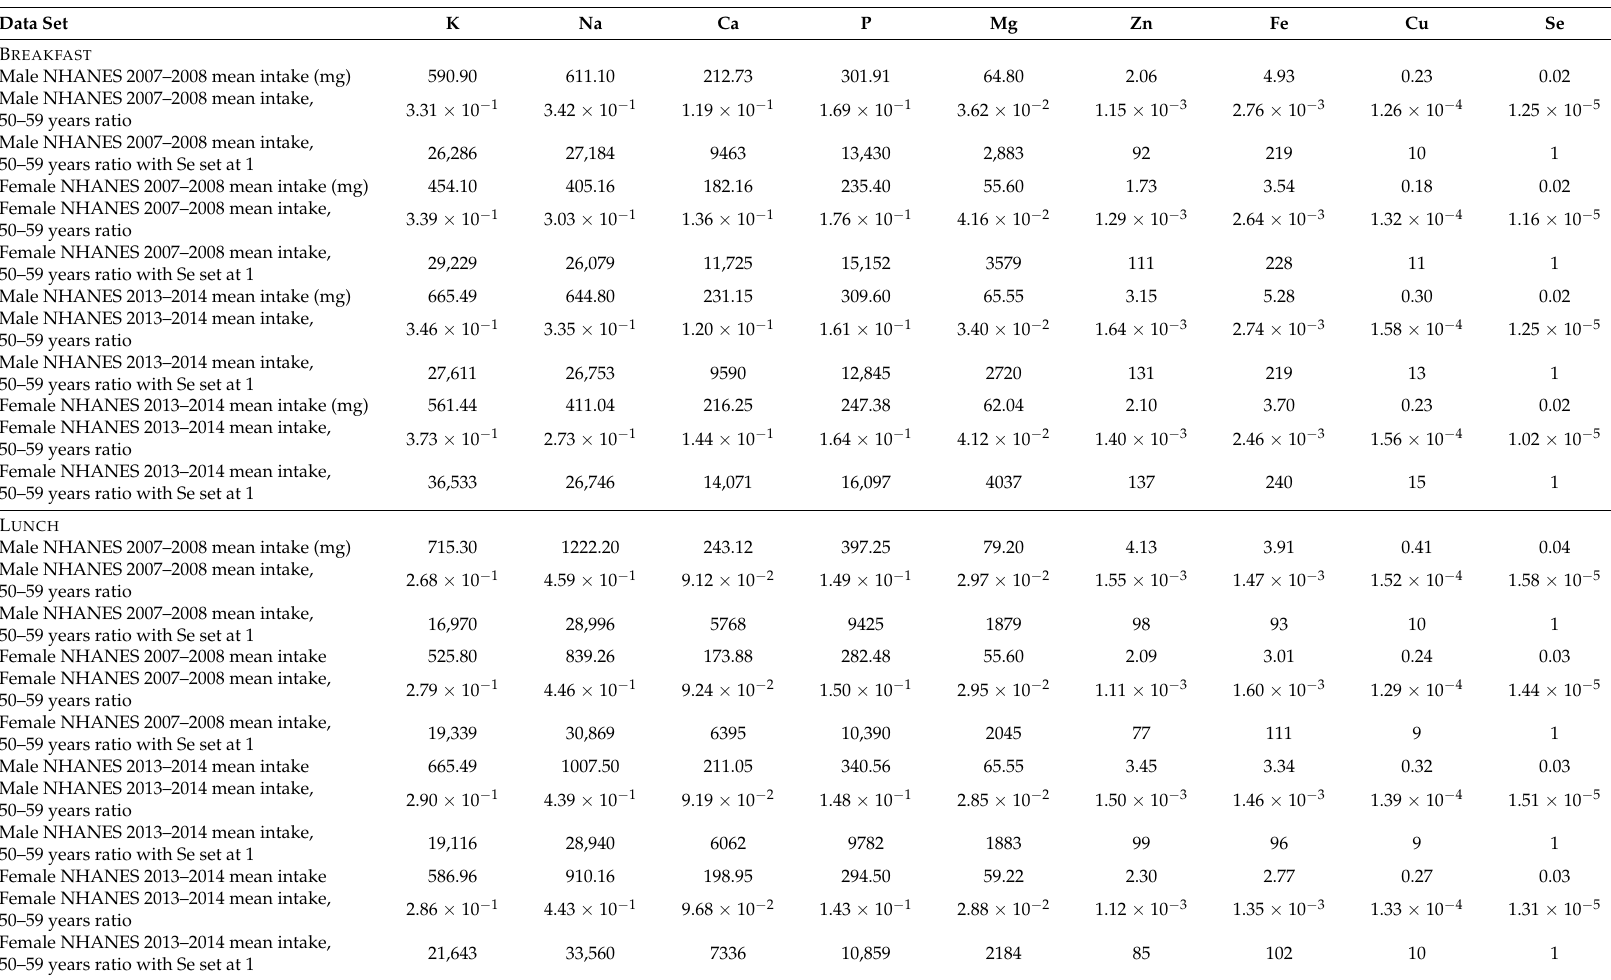
Table 2. The mineral intakes (National Health and Nutrition Examination Survey (NHANES) 2007–2008 and 2013–2014 data), their ratios and their ratios relative to selenium (Se) at meal occasions, for males and females 51–59 years. Data